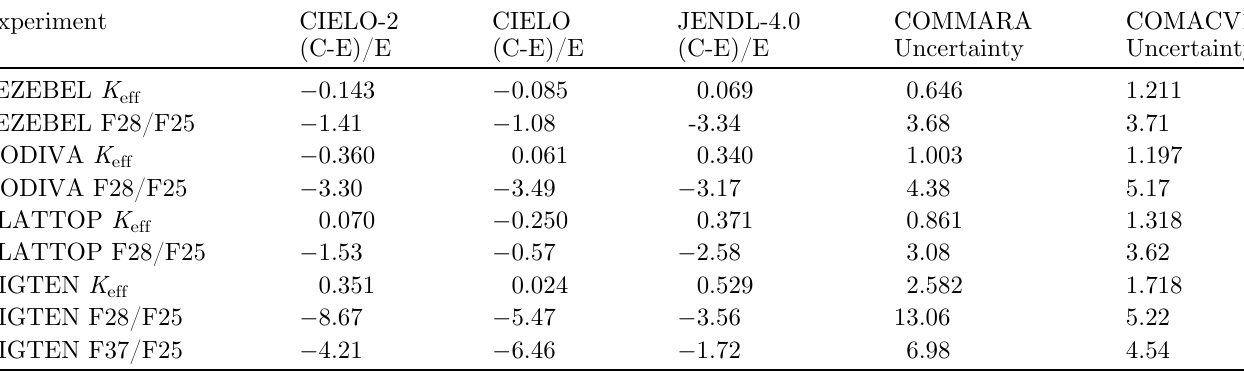
Table 1. (C-E)/E of CIELO and CIELO-2 isotopes and consistency with uncertainty of COMMARA 2.0 and COMACV1: LANL Small Criticals (%).